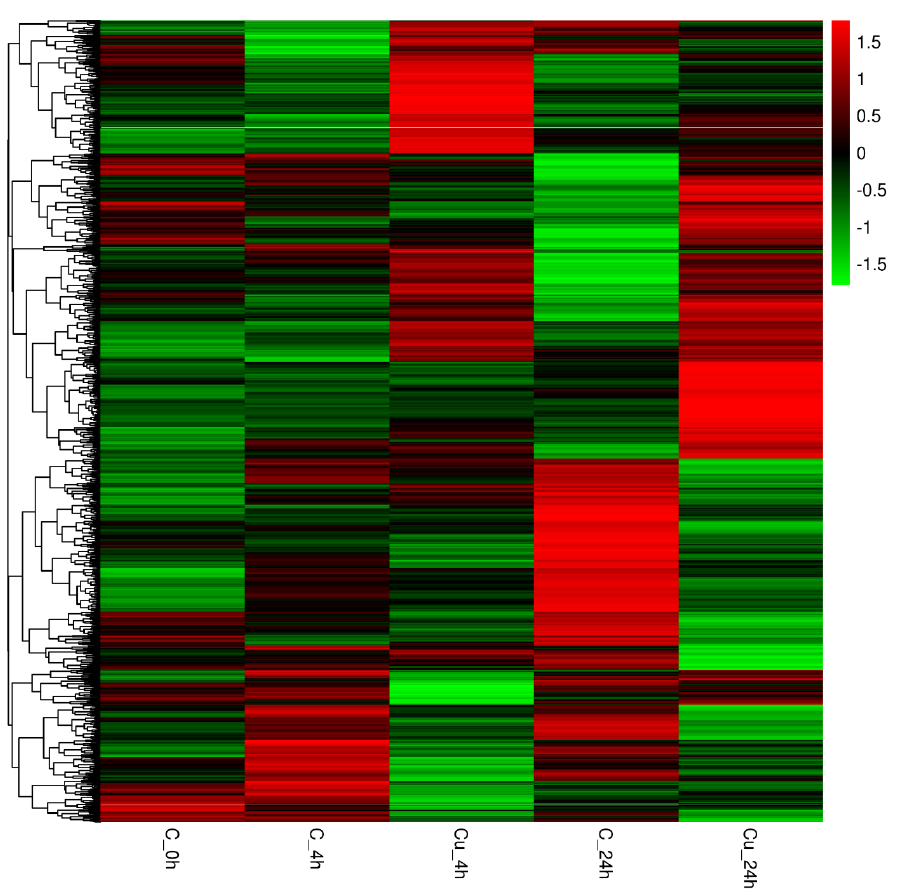
Figure 3. Expression clustering of DEGs. A row indicates expressions of a DEG in each group; each column represents the expressions amount of all DEGs in a group.